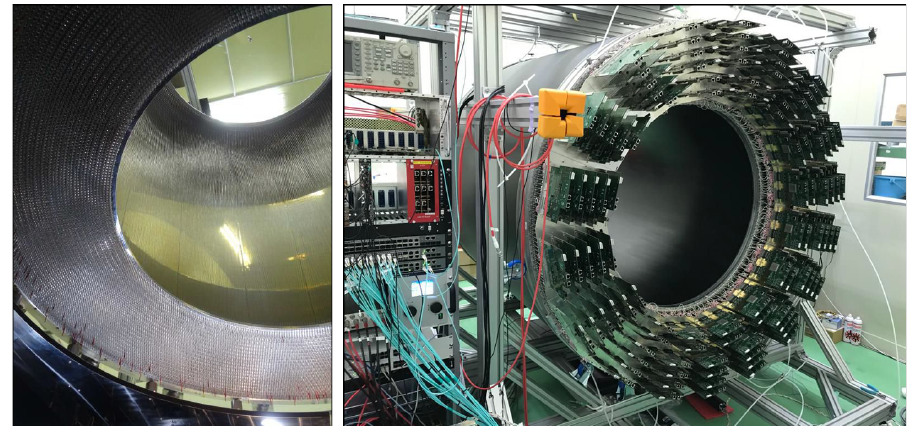
Figure 3. Impression of the finished CDC setup. Left: CDC chamber after the stringing of all 19548 wires. Right: Picture of the drift chamber, including its fully installed data acquisition